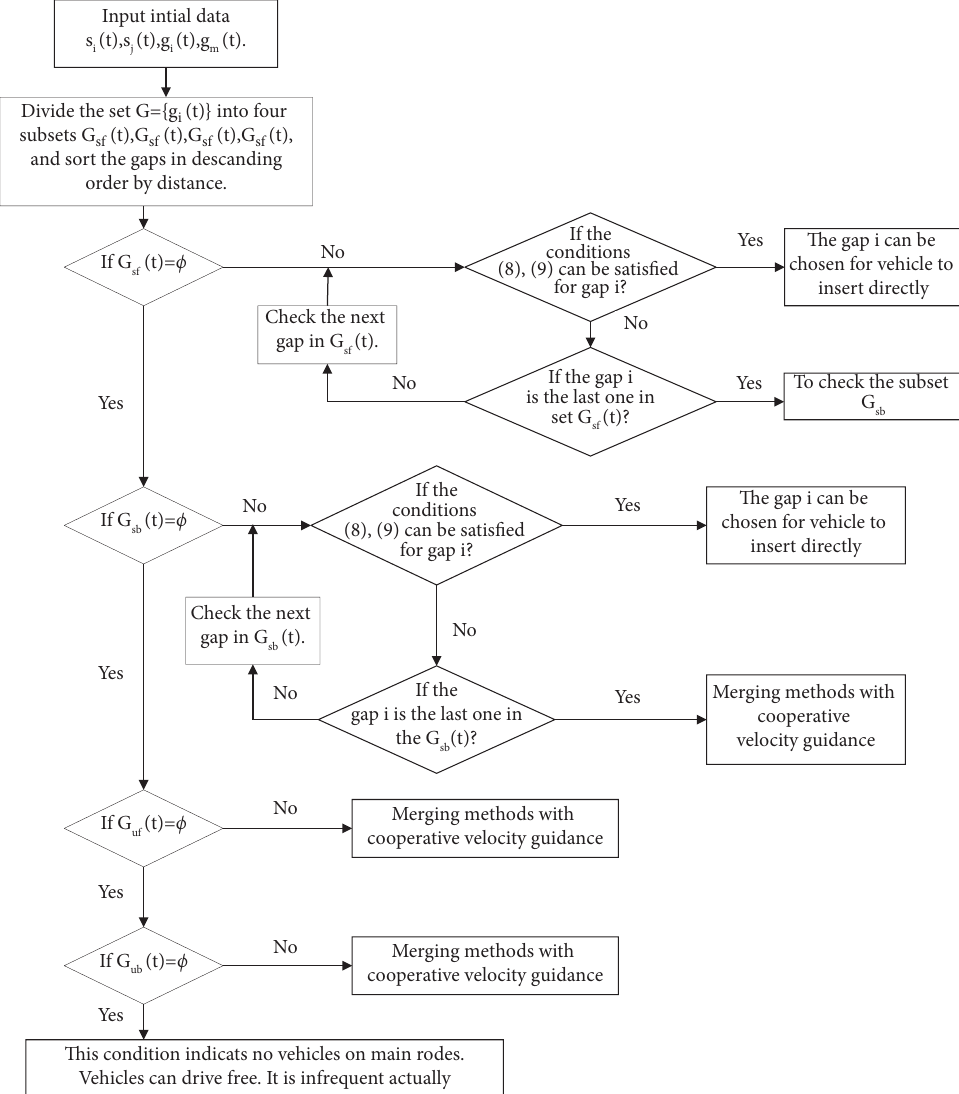
Figure 3: Te fowchart of the gap selection process and priority for diferent